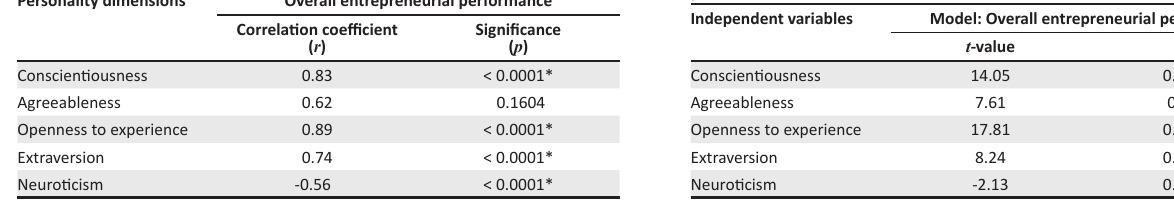
TABLE 5: Regression results of personality dimensions and overall entrepreneurial performance.